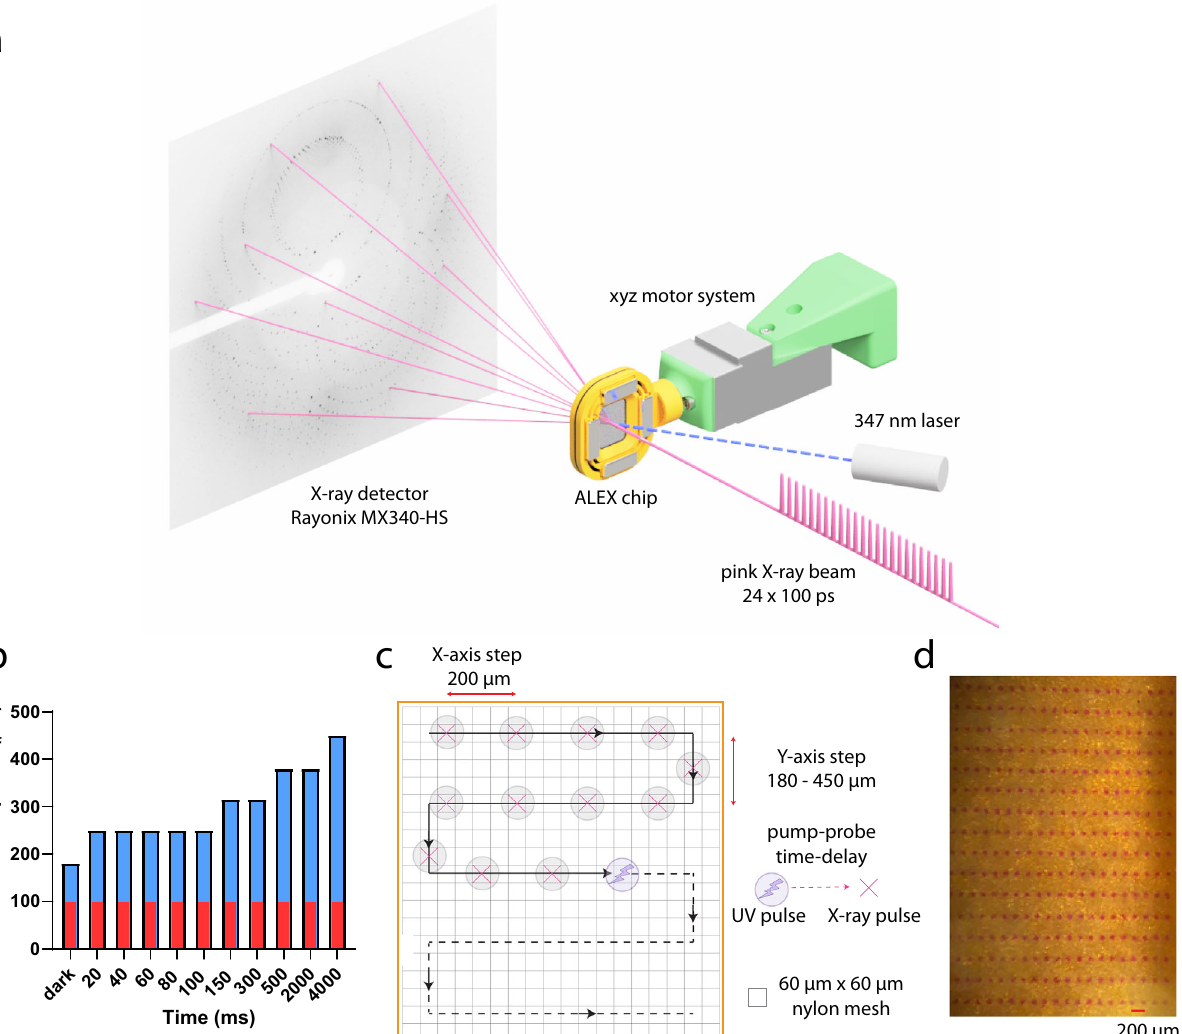
Fig. 1 | Experimental set-up for TR-SSX at 14-ID-B BioCARS beamline. a Polychromatic x-ray beam depicted with simpli fi ed representation of pulse train exposure, containing 24 x-ray pulses with duration of 100ps each and total pulse traindurationof3.7 µ s. ALEX chipmovesduringscaninameander-patternoverthe preset area of the chip containing slurry of immobilized microcrystals. Laser pulse is coordinated with release of x-ray beam by a time delay that corresponds to a speci fi c time point of reaction. The typical Laue diffraction pattern is shown obtainedfrom L1MBLcrystalduring TR-SSX experiment. b Movement of the ALEX chip across the Y -axis with step size labeled as blue bars with an overlaid red